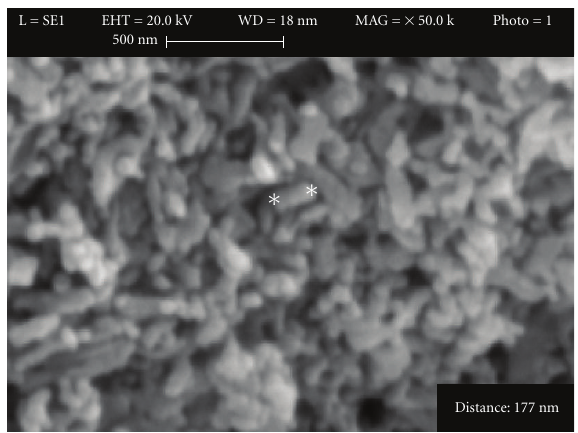
Figure 3: Scanning electron microscopy for synthesized